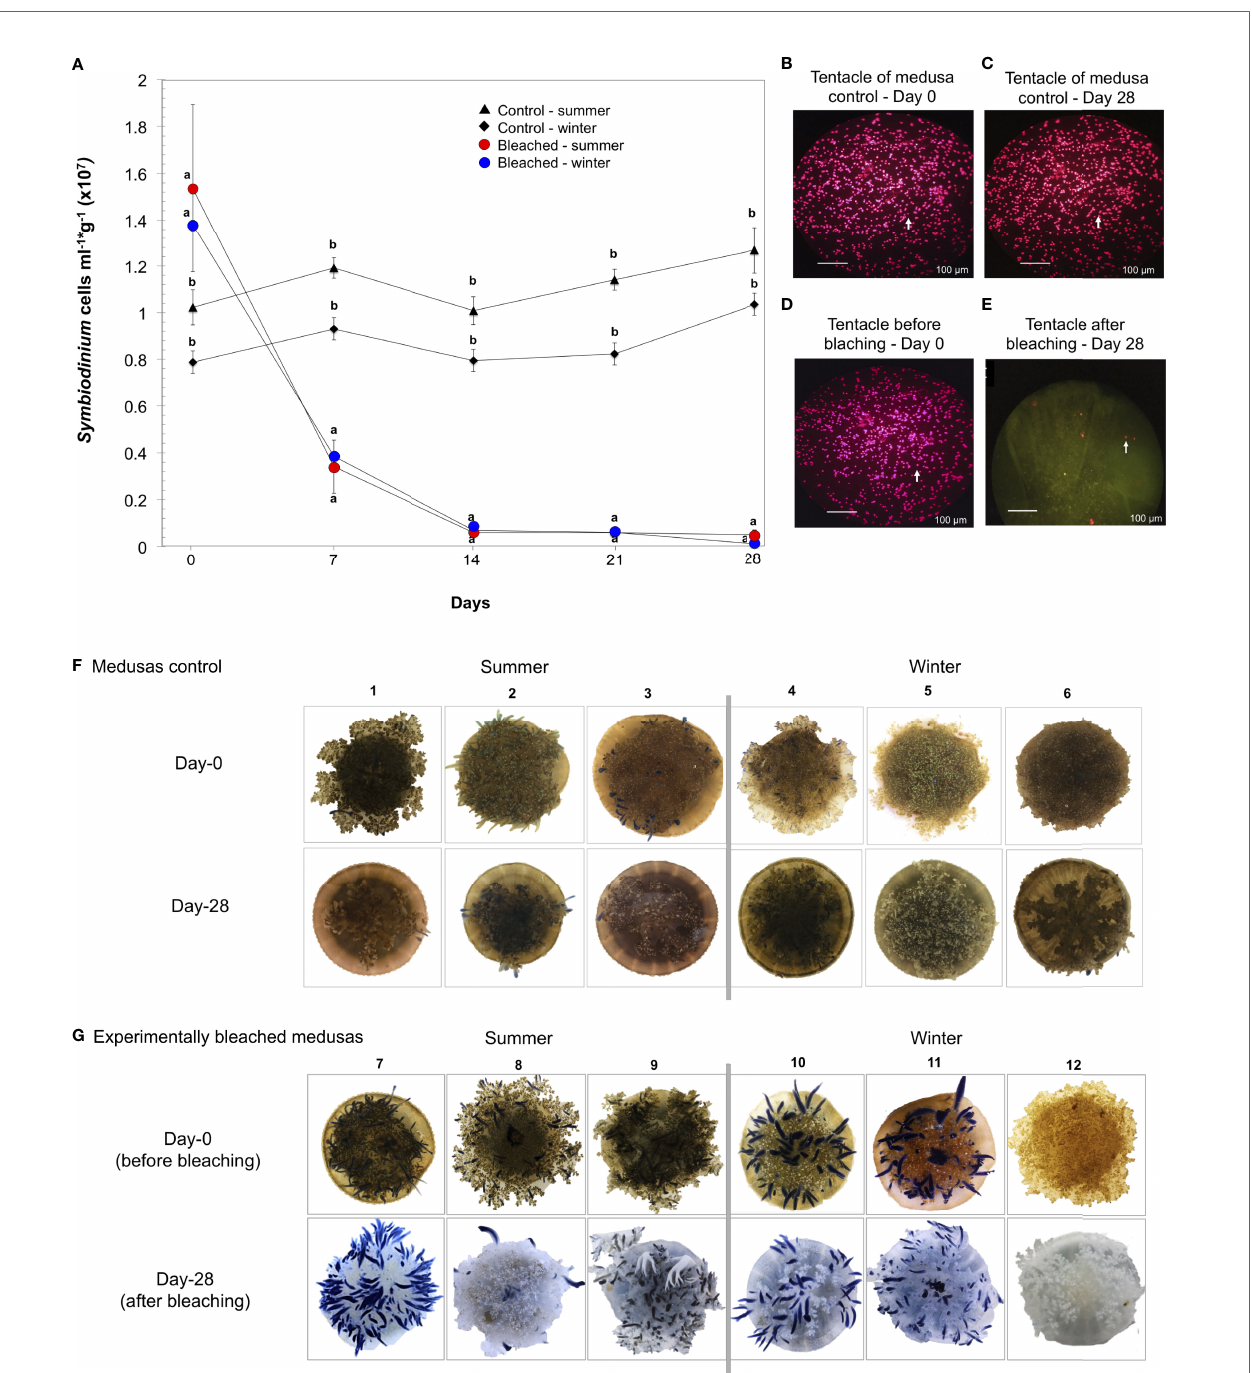
FIGURE 1 | Experimental bleaching and its effects on symbiont density in C. xamachana . Medusas were bleached by daily additions of a mixture of sugars (see Methods). (A) Symbiont cell density (cells ml -1 g -1 ) in medusas treated for 28 days in summer (red circles) and winter (blue circles); control medusas in summer (triangles) and winter (rhombs). Values expressed as the mean ± s.e.m. Letters a and b show signi fi cant differences between the density of symbionts from bleached medusas against control medusas. See Supplementary Material 1 . (B, C) Confocal fl uorescence microscopy images of C. xamachana tentacles of symbiont density in control medusas at day 0 and day 28 and (D, E) symbiont density at the initial (day 0) and end of bleaching treatment (day 28). White arrows indicate symbiont cells in host tentacles, scale bars are 100 m m. (F) Photographs of control medusas from day-0 to 28 days in summer (1-3) and winter (4-6).